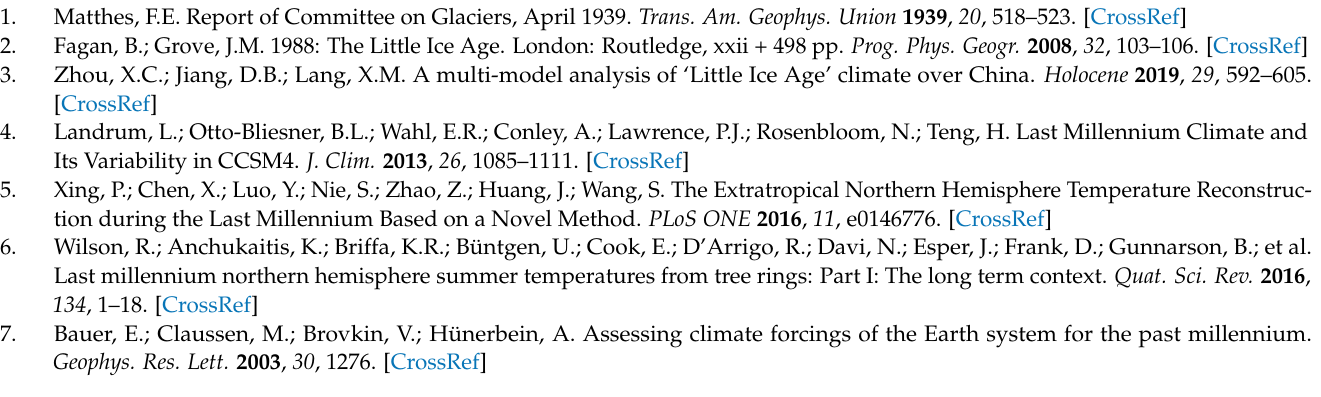
summer mean TX90p (Units: days), TN90p (Units: days) and WSDI (Units: days) indices during 1961–2005 CE in monsoonal China, Figure S3: Time series of simulated and observed TX90p area averaged in monsoonal China during 1961–2005 CE. The units of this index are converted to days, Figure S4: Time series of simulated and observed TN90p area averaged in monsoonal China during 1961–2005 CE. The units of this index are converted to days, Figure S5: Time series of simulated and observed WSDI area averaged in monsoonal China during 1961–2005 CE, Figure S6: Wavelet analyses of TX90p and TN90p in SC from 1400–2005 CE. (a–f) Simulated TX90p by six models. (g–l) Simulated TN90p by six models. The shaded area show the periods with confidence levels higher than 95% and the cone of influence is shown as black line., Figure S7: Trend distribution of summer extreme temperature indices in days per decade from 1650–2005 CE. The dots represent the trends that are significant at a 95% confidence level, Figure S8: Trend distribution of summer extreme temperature indices in days per decade from 1850–2005 CE. The dots represent the trends that are significant at a 95% confidence level, Figure S9: Time series of summer TX90p and TN90p during 1400–2005 CE in NC. The red lines represent the extreme events in Chinese historical documents, Figure S10: Time series of summer TX90p and TN90p during 1400–2005 CE in YRV. The red lines represent the extreme events in Chinese historical documents, Figure S11: Time series of simulated temperature and reconstructed temperature. (a) and (b) Simulated 11-year running annual mean Tmax_anomaly, Tmin_anomaly (units: ◦ C) over monsoonal China. (c) Reconstructed annual mean temperature anomaly of central-east China by Hao et al. (units: ◦ C). Anomalies are calculated related to the reference period (900–1900 CE). Different color lines in (a) and (b) represent individual models and ensemble mean of models. The red lines in Figure S11 (a,b,c) represent the Medieval Climate Anomaly, Table S1: Volcanic and solar forcings used in LM